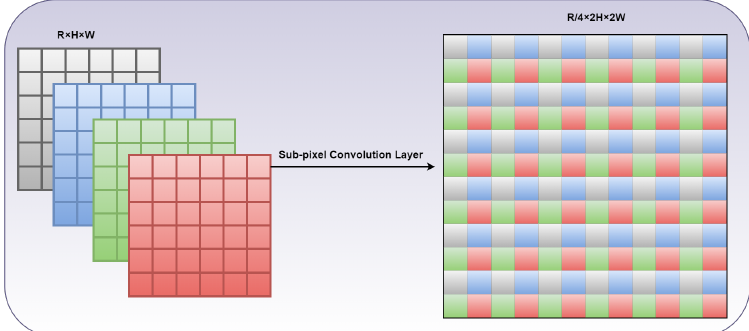
Figure 5. Subpixel convolution upsampling. Subpixel upsampling is mainly used to reconstruct high-quality feature maps in the decoder